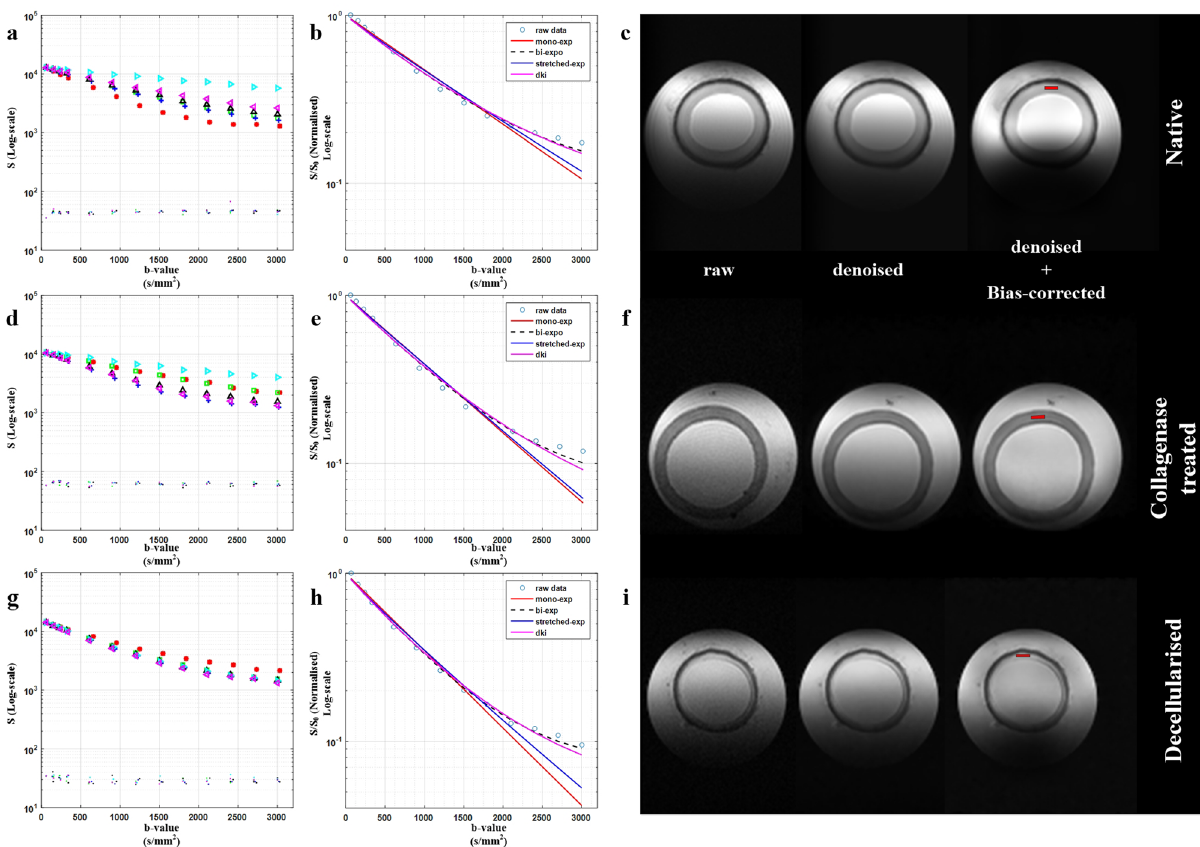
Figure 2. Diffusion-weighted signal decay curves as a function of b-value from the six non-collinear diffusion- encoding directions. Profile of noise corrected diffusion-weighted signal decay curves across six diffusion- encoded directions (HMb protocol) for ( a ) native tissue, ( d ) collagenase treated tissue and ( g ) decellularized tissue samples. In ( a , d , g ), the calculated signal noise floor is also shown. ( b , e , f ) The comparison of various signal representation based fitting schemes on the actual noise and bias corrected diffusion-weighted signal (for illustration purpose, the DW-signals from the sixth diffusion-encoded direction were used in b , e and h ). ( c , f , i ) The b0 images of native, collagenase treated and decellularized tissues samples, respectively. The noise floor was calculated using the standard deviation of the background signal from a region (16 × 16 × 16 voxels) within the “Reference Power